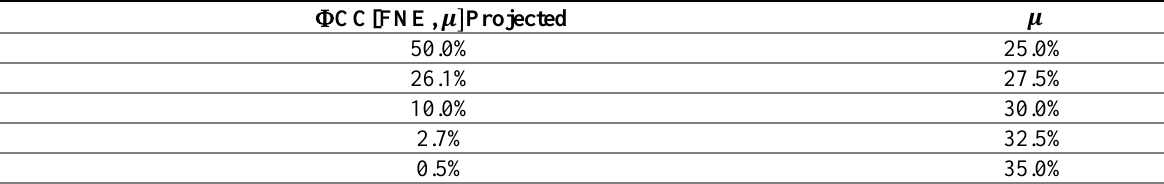
Table 1: Study OCC Projection Context for the